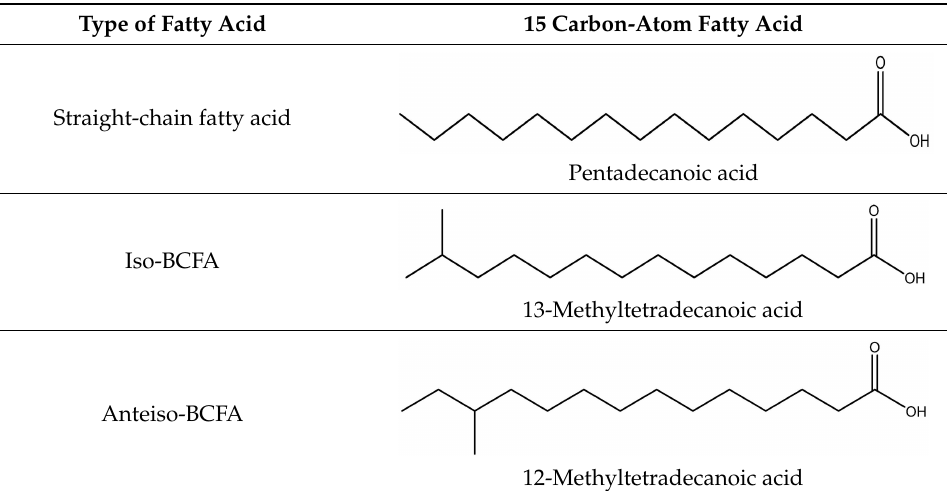
Table 1. Structural differences among straight-chain fatty acid, iso- and anteiso-BCFA. BCFA— branched-chain fatty acid.